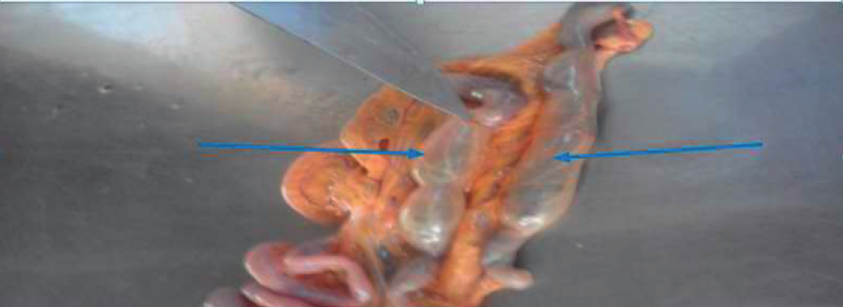
Figure 4: Arrows showing paired ceca of the avian intradermal tuberculin test positive chicken filled with air and cecal walls devoid of epithelial cells and connective tissue as observed upon postmortem